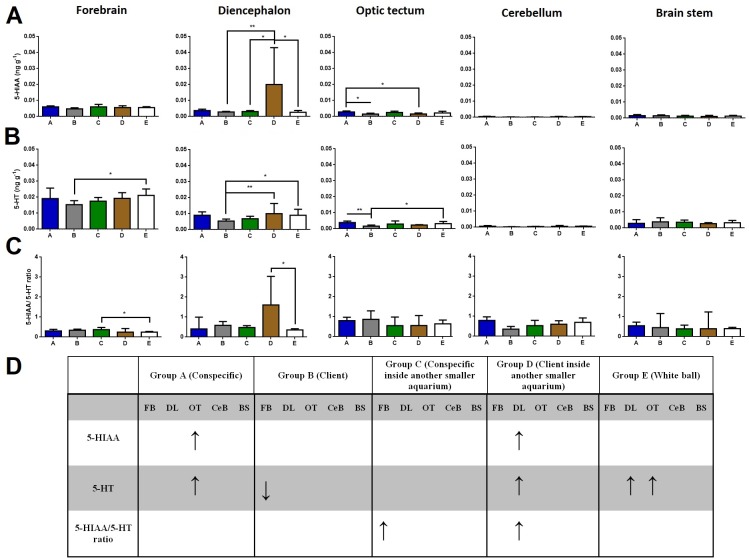
5-HIAA, 5-HT, and 5-HIAA/5-HT ratio in different brain areas, and different treatments.(A) 5-HIAA levels, in the forebrain (K = 7.657; p = 0.105), diencephalon (K = 14.78; p = 0.0052), optic tectum (K = 13.95; p = 0.0074), cerebellum (K = 11.85; p = 0.0185), brain stem (K = 2.809; p = 0.5903); (B) 5-HT levels, in the forebrain (K = 11.05; p = 0.026), diencephalon (K = 17.55; p = 0.0015), optic tectum (K = 17.9; p = 0.0013), cerebellum (K = 10.09; p = 0.0389), brain stem (K = 3.821; p = 0.4307); (C) 5-HIAA/5-HT ratio, in the forebrain (K = 10.73; p = 0.0298), diencephalon (K = 9.69; p = 0.0460), optic tectum (K = 6.996; p = 0.1361), cerebellum (K = 5.843; p = 0.2112), and brain stem (K = 2.47; p = 0.6500); (D) significant changes in different social contexts. Medians and interquartile ranges are shown. Significant values are shown above bars: * <0.05; ** <0.01; and refer to Dunn’s Post-Hoc tests.